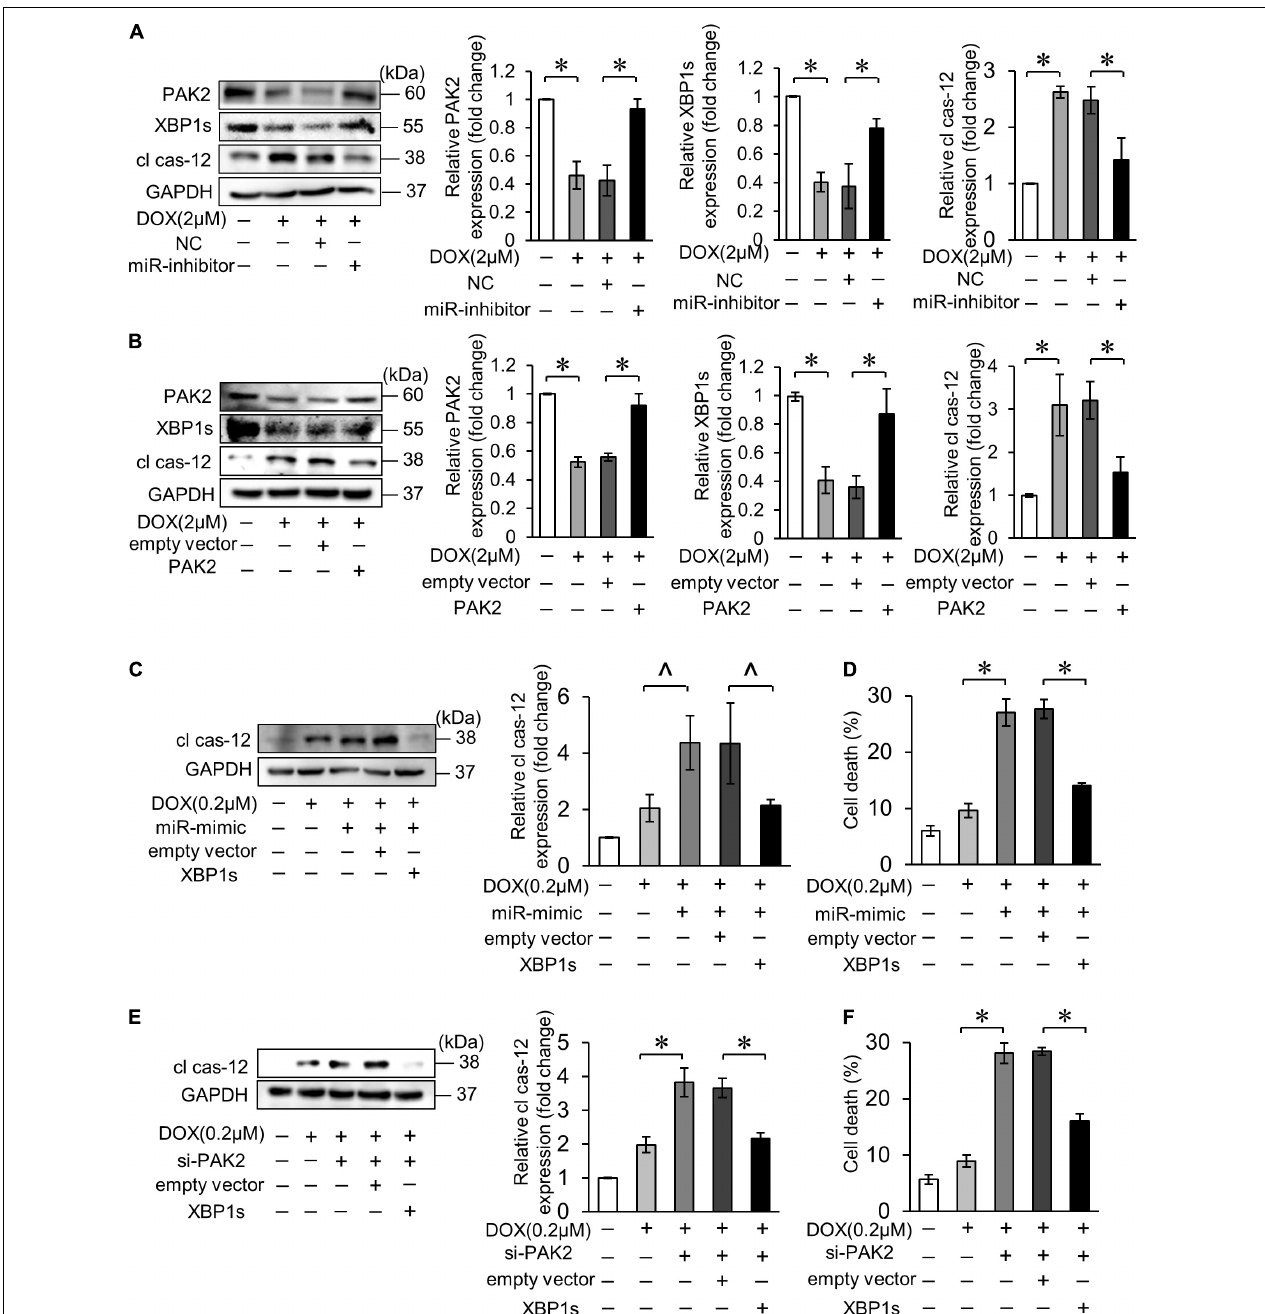
FIGURE 6 | MiR-194-5p participated in DOX-induced ER stress and cardiomyocyte apoptosis through PAK2 and XBP1s. (A) Suppressed miR-194-5p expression with miR-194-5p inhibitor for 24 h and exposed to 2 µ M DOX for 24 h. The expression levels of PAK2, XBP1s, and cleaved caspase-12 were detected by Western blot and the quantitative histogram was shown. (B) Enhanced PAK2 expression with PAK2-overexpressing plasmid for 24 h and exposed to 2 µ M DOX for 24 h. The expression levels of PAK2, XBP1s, and cleaved caspase-12 were detected by Western blot and the quantitative histogram was shown. (C,D) H9c2 was cotransfected with miR-194-5p mimic and XBP1s-overexpressing plasmid for 24 h, then exposed to 0.2 µ M DOX for 24 h. The expression levels of cleaved caspase-12 were detected by Western blot and the quantitative histogram was shown (C) and cell death rate was analyzed (D) . (E,F) H9c2 was co-transfected with PAK2 siRNA and XBP1s-overexpressing plasmid for 24 h, then exposed to 0.2 µ M DOX for 24 h. The expression levels of cleaved caspase-12 were detected by Western blot and the quantitative histogram was shown (E) and cell death rate was analyzed (F) . All the experiments have been performed independently in triplicate, and the data were expressed as mean ± SD. ∧ p < 0.05 vs. control. ∗ p < 0.01 vs. control.